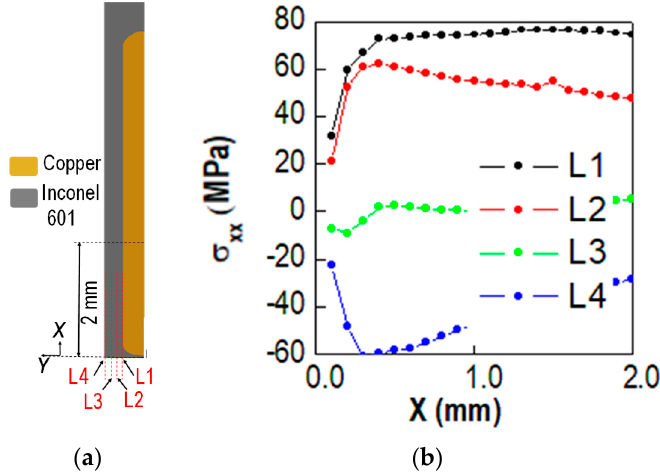
Figure 10. Stress distribution in the sample. ( a ) Schematic electrode geometry with 4 lines (L i ) defined in the Inconel coating. ( b ) Axial stress ( σ xx ) in the Inconel along lines L i . During heating, copper expansion induces compressive loading along the copper–Inconel